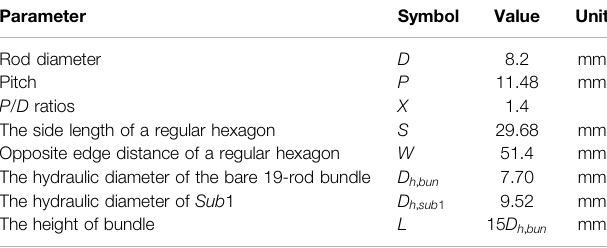
TABLE 1 | Geometric parameters of the bare 19-rod bundle. Parameter